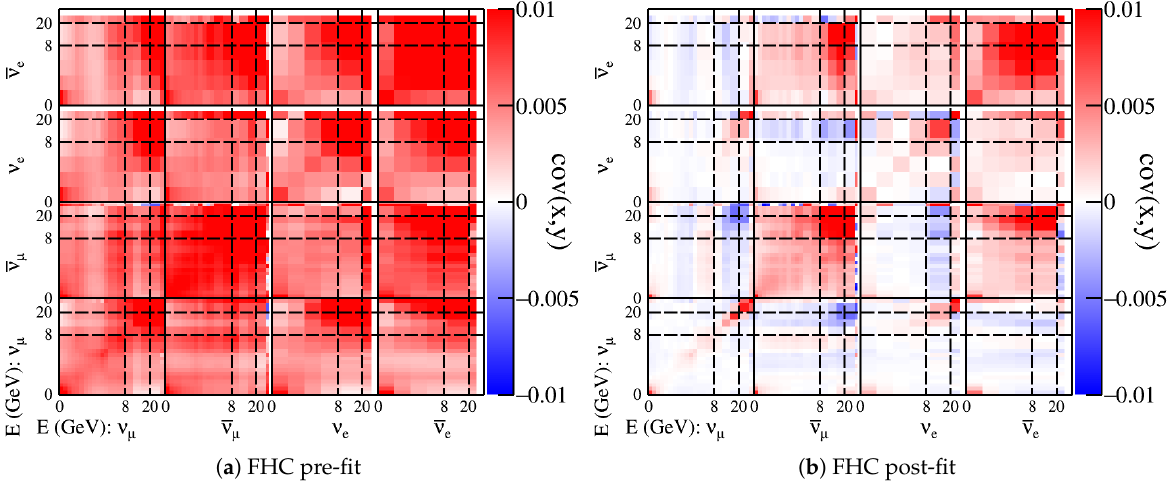
Figure 39. Pre- and post-fit FHC flux covariance matrices for an effective 30t LAr detector using a five-year exposure of the baseline 1.2MW beam.